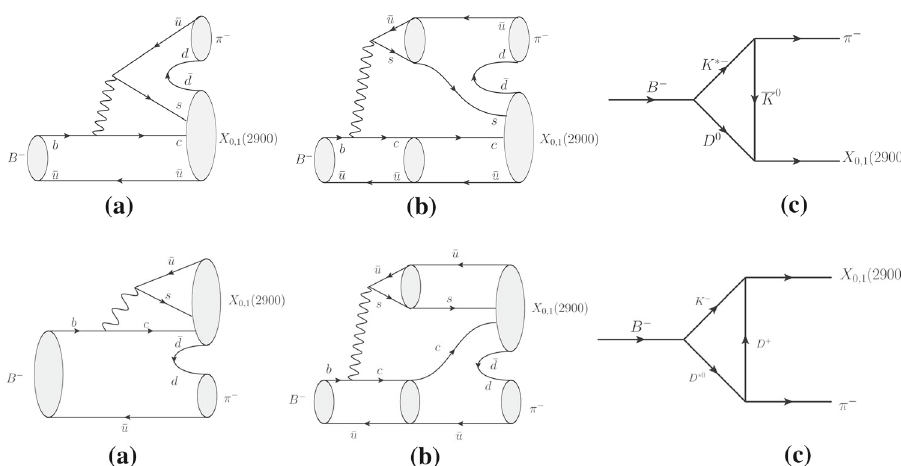
Fig. 7 Similar to Fig. 4 but for B − → π − X 0 , 1 ( 2900 ) . Those three diagrams are very similar to B − → D − X 0 , 1 decays with a charm anti-quark replaced by an up anti-quark